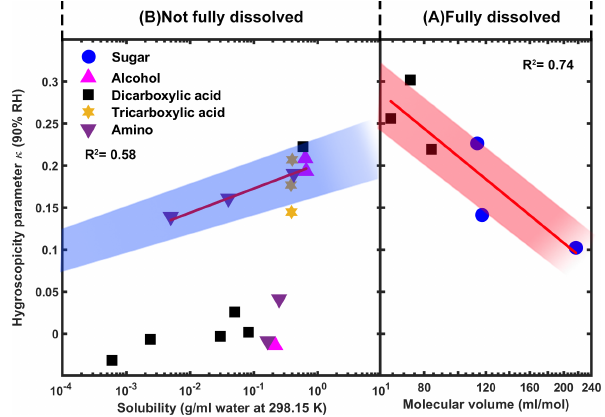
Figure 6. Hygroscopicity of organic compounds as a function of molecular volume (A) and solubility